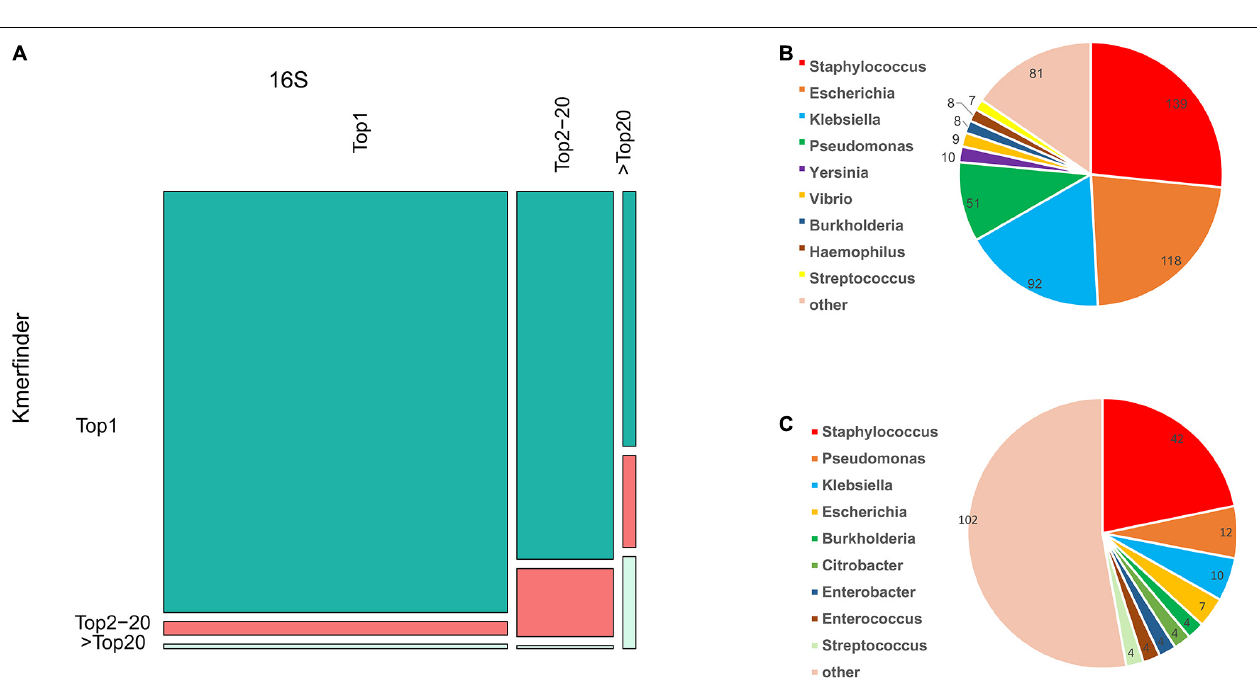
FIGURE 2 | Bacterial species coverage in different methods compared to three datasets. (A) GEBA dataset; (B) FDA-ARGROS dataset; and (C) NCTC 3000 dataset. The color light green indicates the percentage of taxon from the corresponding dataset that was not covered by the reference database from each method. The percentage of taxon of the corresponding dataset covered by the reference database was divided into two parts, complete genomes (orange) and draft genomes (green). Kmerfinder_bac, the complete genome database from KmerFinder; kmerfinder_type, genomes of type strains from KmerFinder; fIDBAC, curated genomes of type strains from fIDBAC.